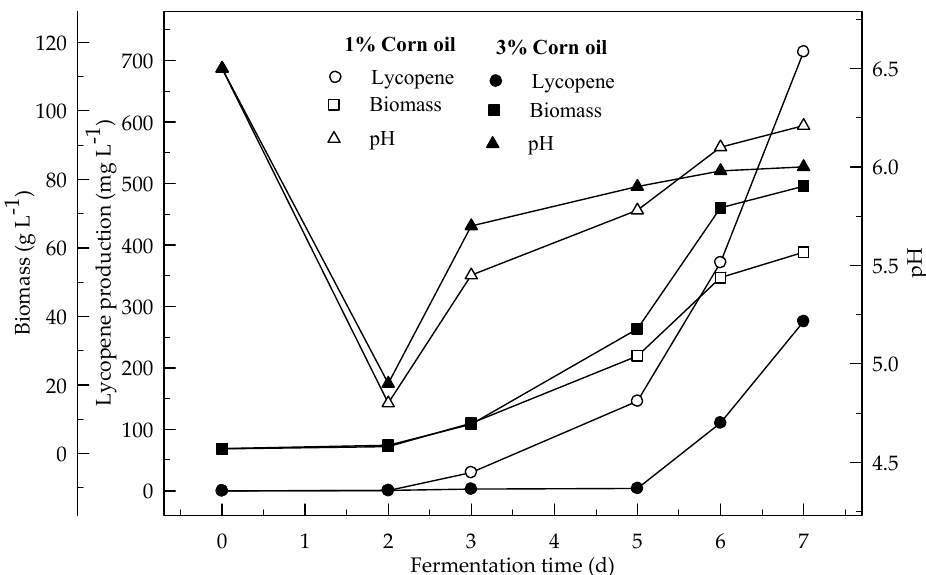
Figure 4. Changes in lycopene production, biomass formation and pH in fermentation with an initial pH 6.5 in a 4% glucose medium containing 1 and 3% corn oil.